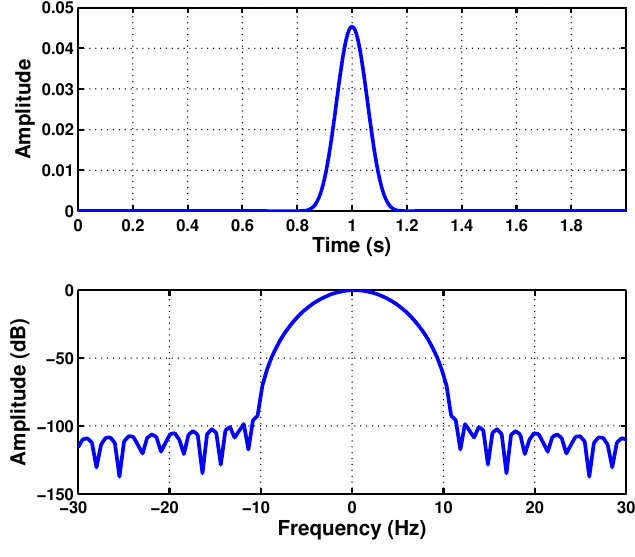
Figure 6. Slepian window ( B W = 20.85 Hz, T W = 383.7 ms) optimized for the maximum overlap with the LSH trajectory in the time domain ( top ) and in the frequency domain ( bottom